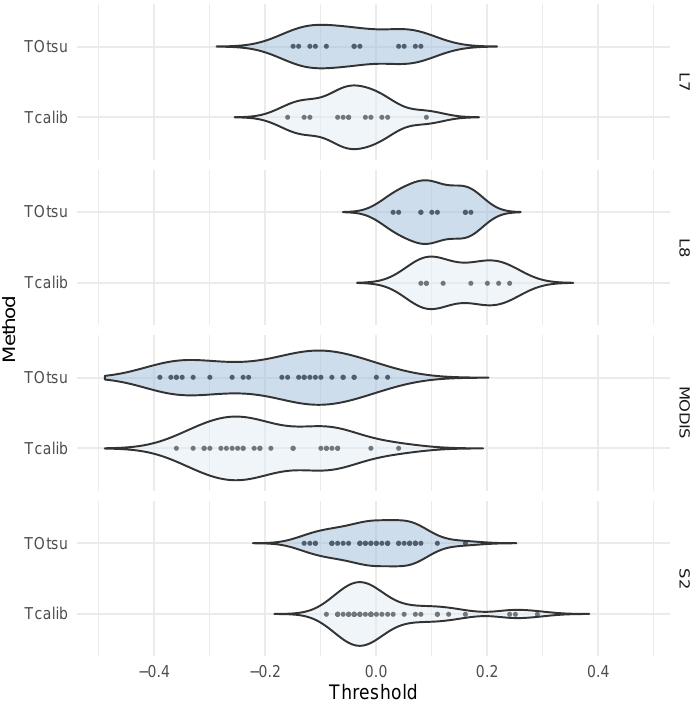
Figure 4. Comparison of the optimal threshold based on the Otsu algorithm (TOtsu) and on the calibration against field data (Tcalib) for Landsat 7, Landsat 8, MODIS and Sentinel-2.